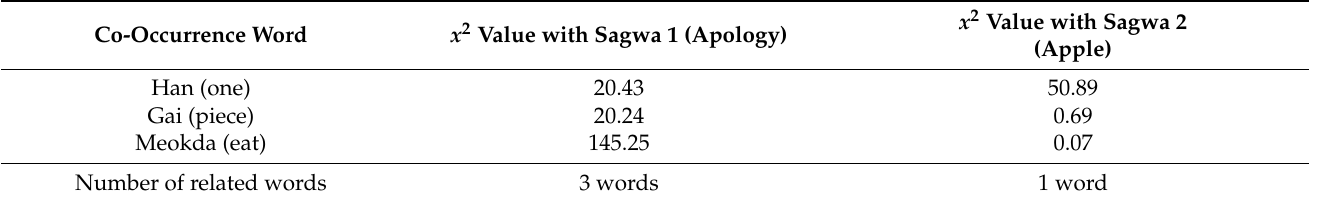
Table 2. Relationship analysis between words using the chi-square test of independence.